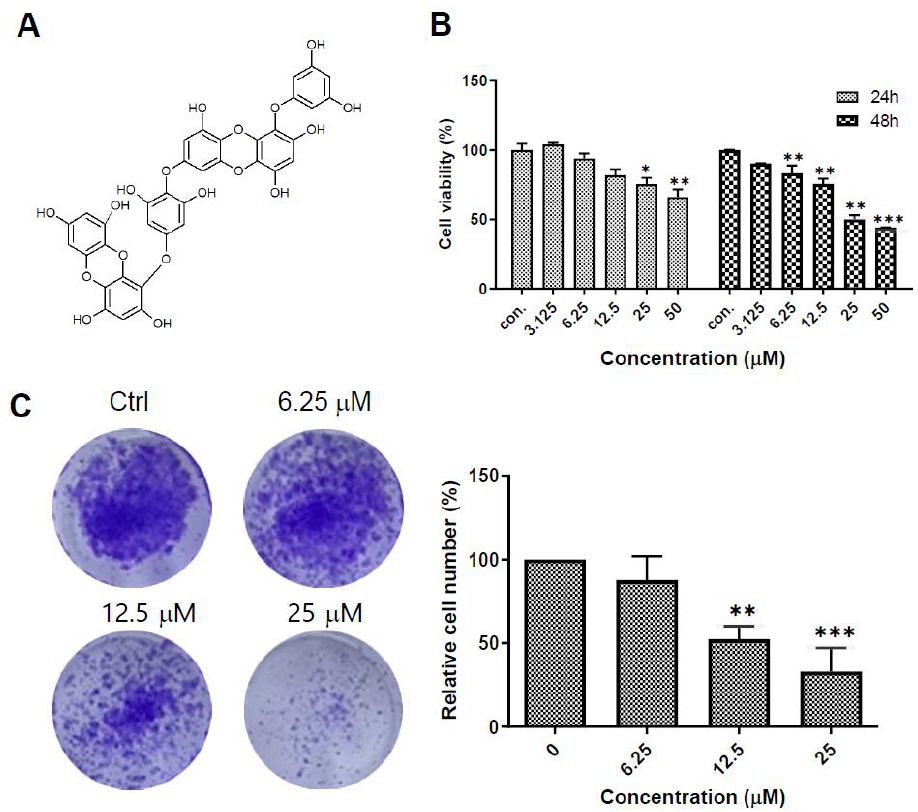
Figure 1. Dieckol (DK) suppresses proliferation and colony formation of A375 human melanoma cells. ( A ) Chemical structure of the DK molecules. ( B ) A375 cells were treated with indicated con- centration of DK for 24 h or 48 h and the cell viability was measured by MTT assay. Results are shown as mean ± standard deviation (SD) of triplicate independent experiments. ( C ) Representative images of the colony formation assay and a bar graph showing the colony area. Results are shown as mean ± SD. *** p < 0.001, ** p < 0.01, * p < 0.05 compared to the control. 2.2. Dieckol Induces Caspase-Mediated Apoptosis in A375 Cells We examined whether dieckol-induced A375 melanoma cell death is associated with apoptosis. The A375 cells were double stained with annexin V/propidium iodide (PI) and analyzed using flow cytometry to assess the apoptosis rate. Dieckol caused annexin-posi- tive phosphatidylserine plasma membrane externalization and loss of membrane integrity underlying PI positivity. The percentage of annexin V/PI double-positive late apoptotic cells increased in a dieckol dose-dependent manner (Figure 2A). The effect of dieckol on apoptosis was further determined by assessing the levels of key proteins involved in apoptosis signaling. Dieckol treatment activated caspase-3 and poly (ADP-ribose)-poly- merase 1 (PARP1). There was a significant increase in the cleaved caspase-3 and PARP1 in cells treated with dieckol (Figure 2B). In addition, dieckol decreased the level of the anti-apoptotic protein B-cell lymphoma-2 (Bcl-2) but increased the levels of proapoptotic proteins Bcl-2 homologous antagonist/killer (Bak), Bcl-2-associated X protein (Bax), and Bcl-2 interacting mediator of cell death (Bim). These results suggested that dieckol induces caspase-dependent apoptosis downstream of the Bcl-2 family. Thus, we treated the cells with dieckol in the presence or absence of the fan-caspase inhibitor Z-VAD-fmk (Z-VAD)